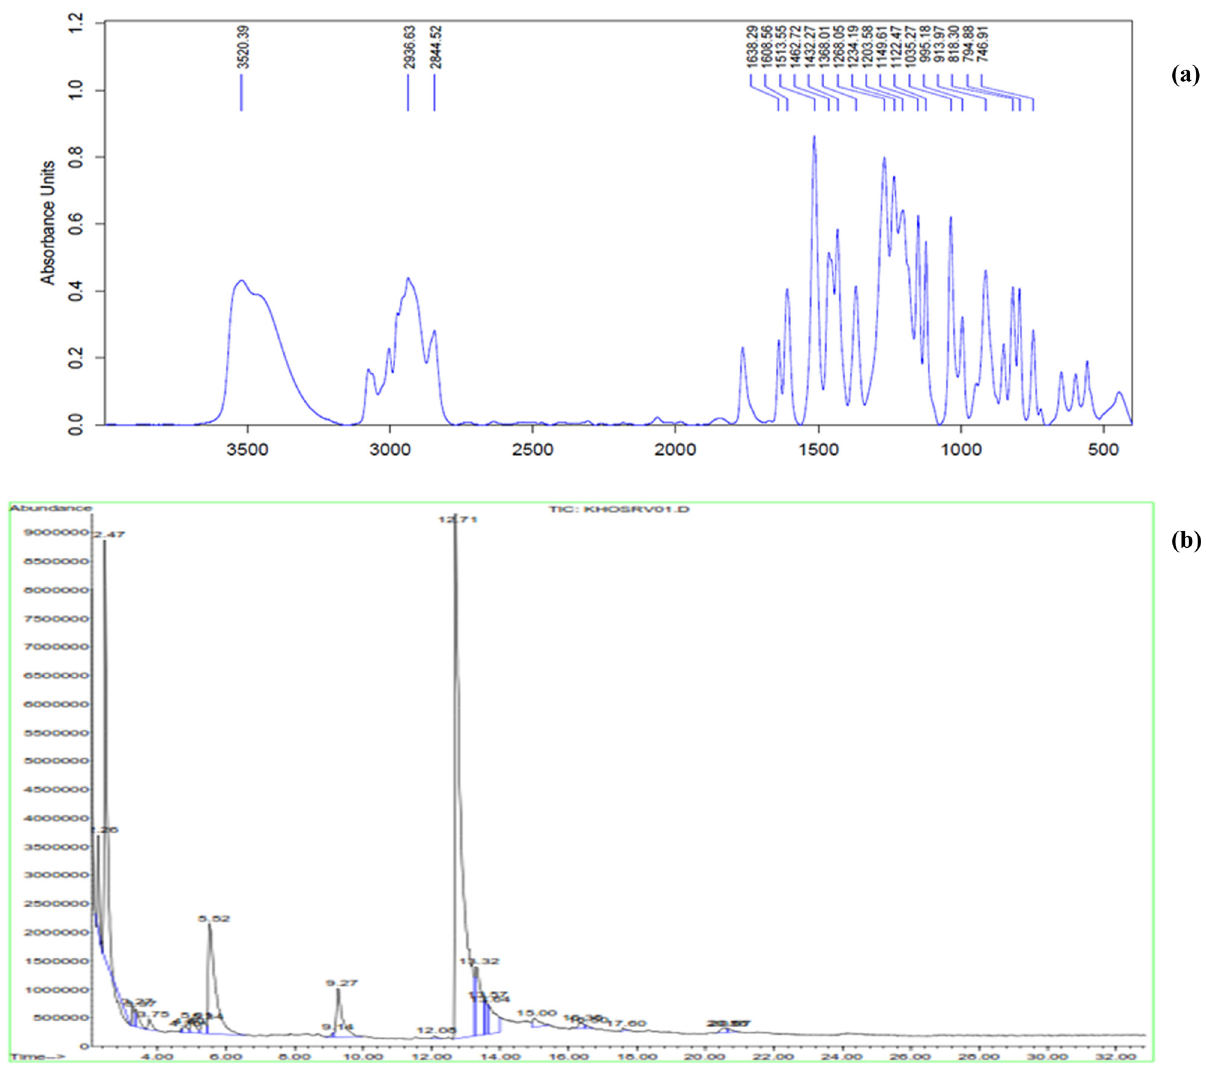
Figure 1: FT - IR spectra ( a ) and GC - MS chromatogram ( b ) of the clove ( Syzygium aromaticum Linn )